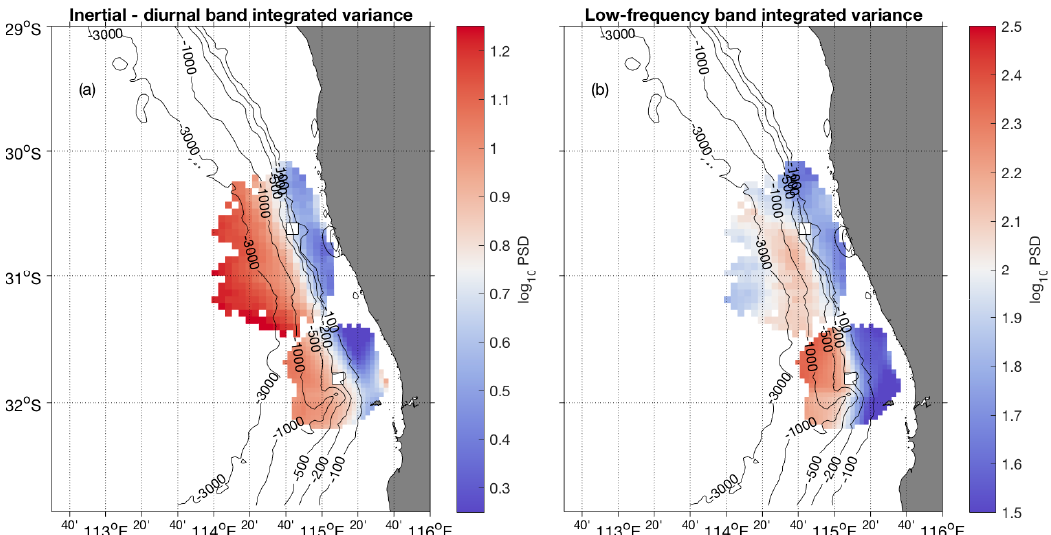
Figure 11. Spatial distribution of band-integrated current variance for ( a ) diurnal-inertial, corresponding to periods in the range [21 h 44 m 20.8 s, 26 h 18 m 56.8 s]; and, ( b ) low-frequency (periods longer than 4 days). Note the discontinuity along the 200 m isobath, separating the shelf break and the deep-water regions. Units for band-integrated variance is log 10 (m 2 s − 2 cph − 1 ).